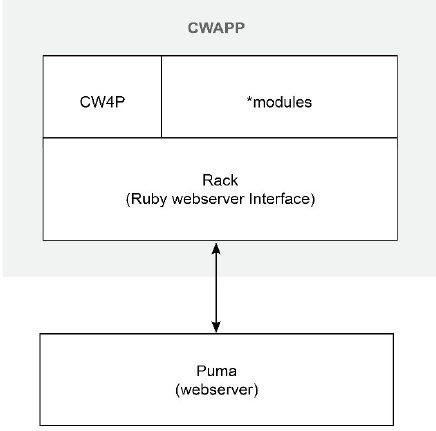
Figure 4. CWAPP application components. Source: adapted from [10].